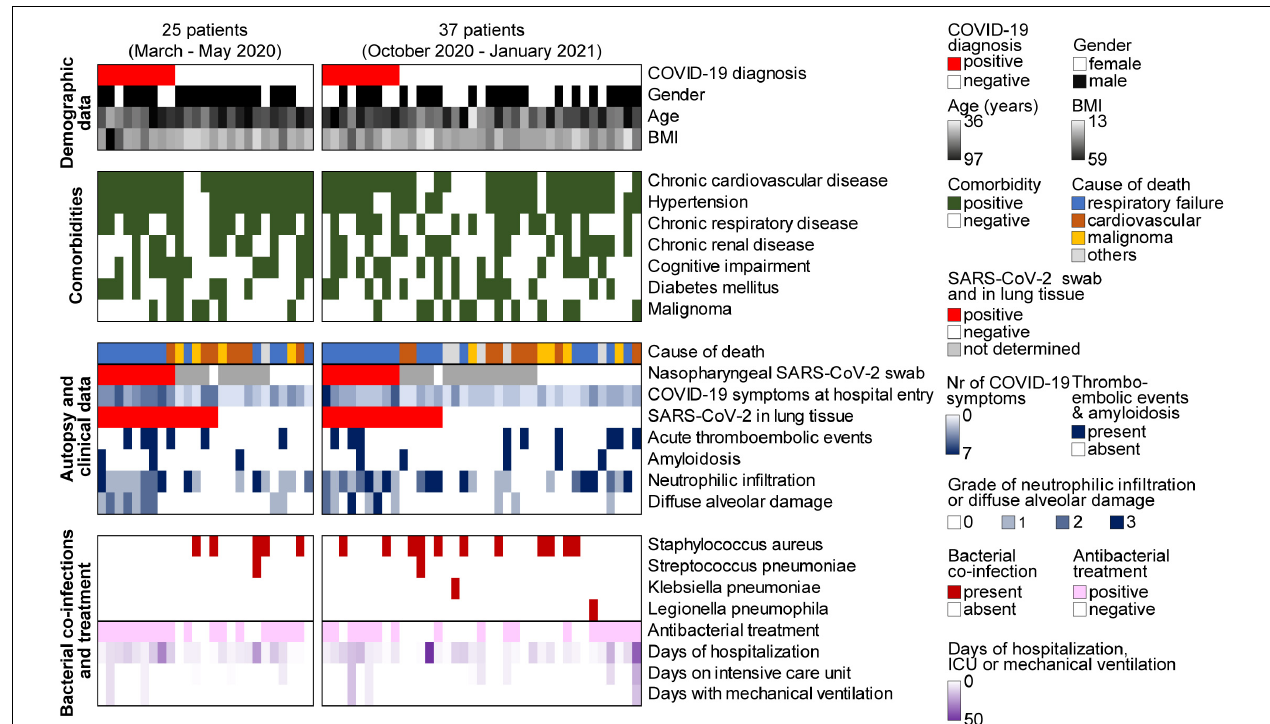
FIGURE 2 | Overview of patient characteristics, clinical data, and autopsy findings of all 62 autopsies during the first ( n = 25) and second ( n = 37) wave of the COVID-19 pandemic. BMI, body mass index; ICU, intensive care unit.